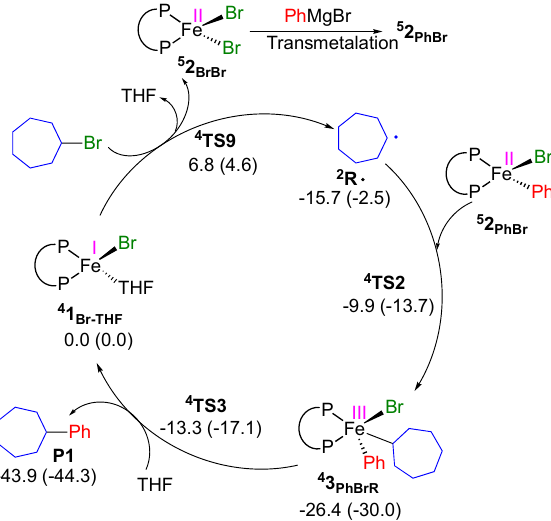
Figure 6. Revised catalytic cycle of iron-SciOPP catalyzed-KTC coupling of a haloalkane based on the current DFT study. Free energies with respect to 4 1 Br-THF and bromocycloheptane are given in kcal/mol (ΔE ZPE are given in parenthesis).